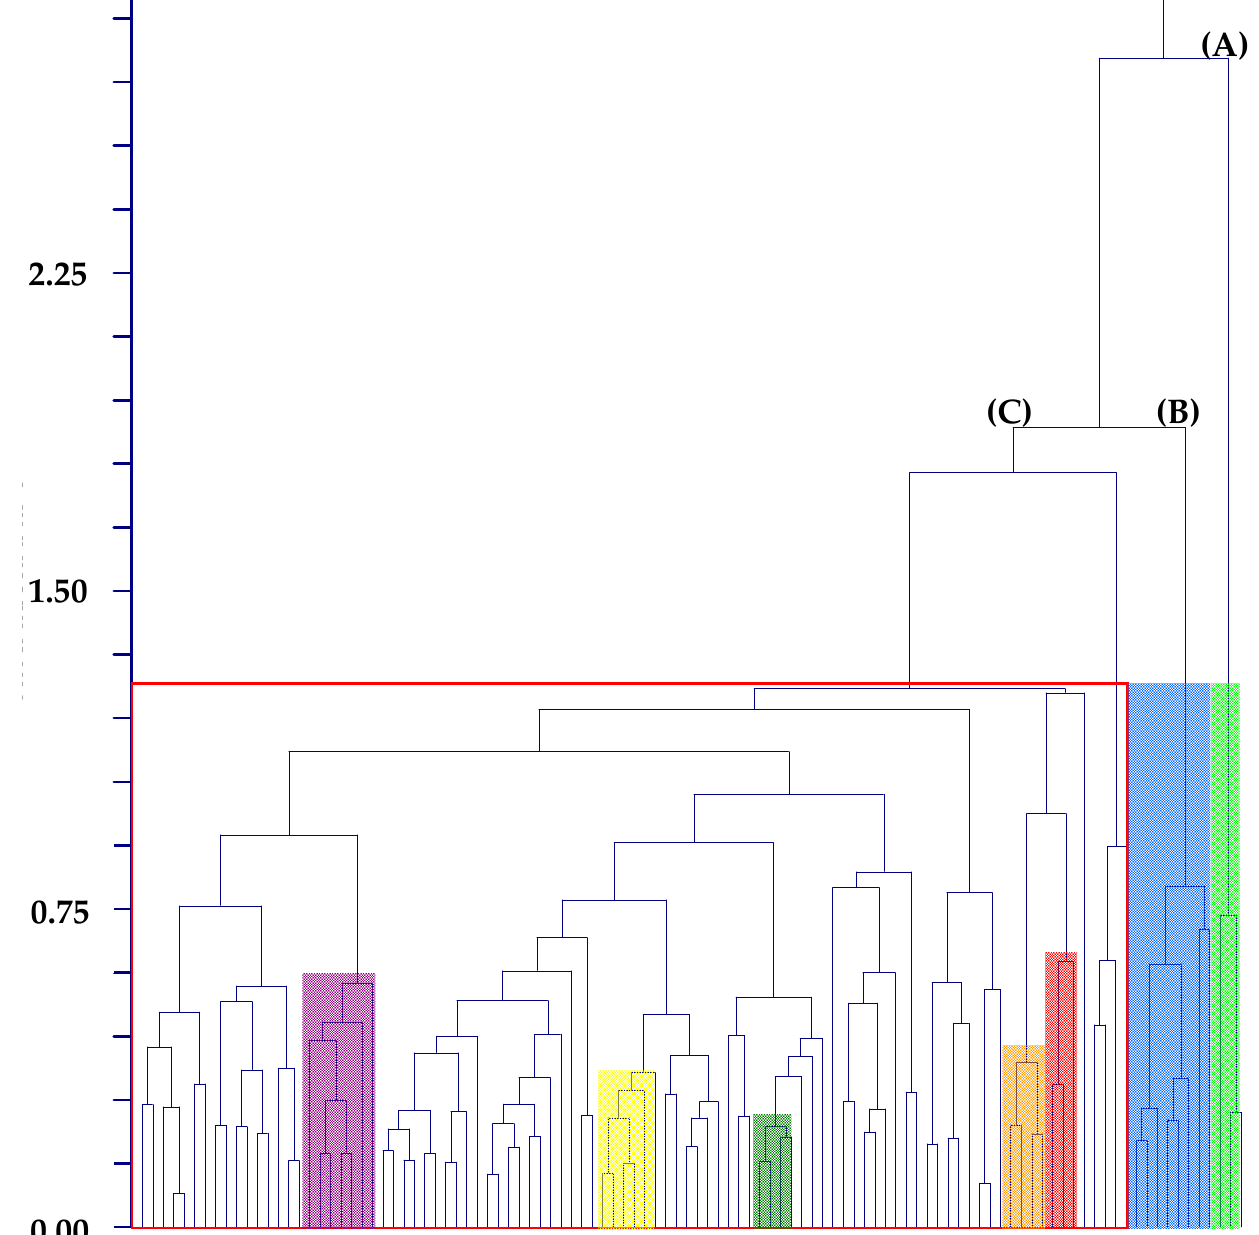
Figure 2. Dendrogram graph (hierarchical clustering, UPGMA method) of Amaranthus taxa in- vestigated. Main clades: (A) = crassipes -group (light green); (B) = muricatus / viridis -group (blue); (C) = residual-group (square with red sides). Secondary clades: centralis -group (orange), graecizans - group (violet), induratus -group (red), retroflexus -group (yellow), vulgatissimus -group (dark green). The DA shows different results depending on the use of the names of the taxa (species and below ranks or subgenera) or Waselkov’s “molecular clades” [15]: (1) By classifying the samples using the taxa names [species and below ranks (25 groups); see Table 1], DA predicted two main groups (Figure 5) based on the first two dis- criminant functions, which explain 71.3% of the total variation [eigenvalues: 52.2% (first function) and 19.1% (second function)]. These two groups (not overlapping each other) correspond to (a) the muricatus / viridis -group and (b) a large group